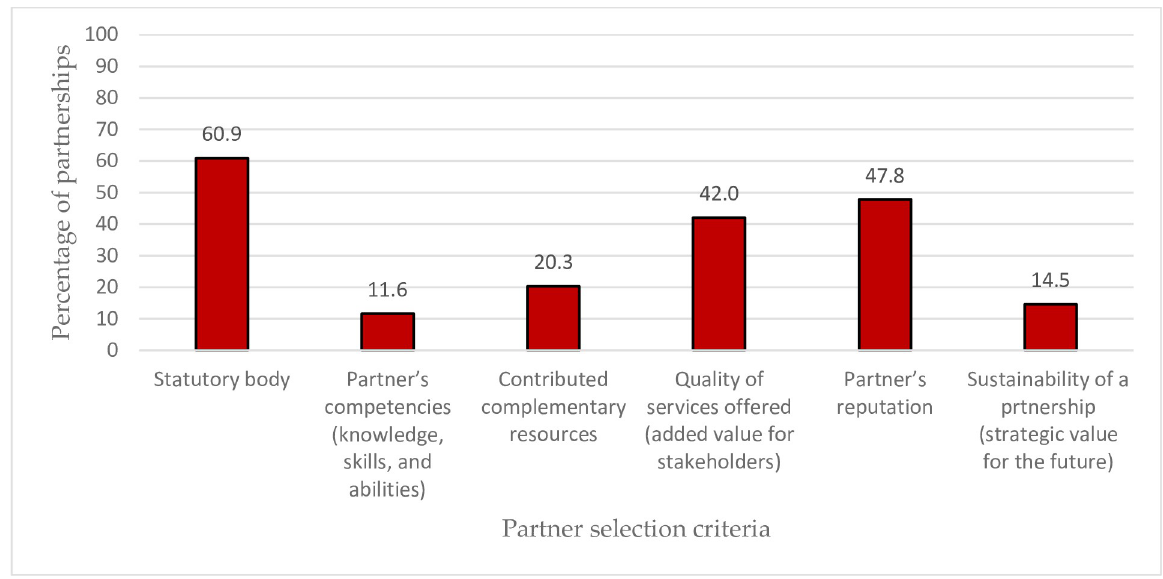
Fig 2. The partner selection criteria applied by the agricultural cooperatives.